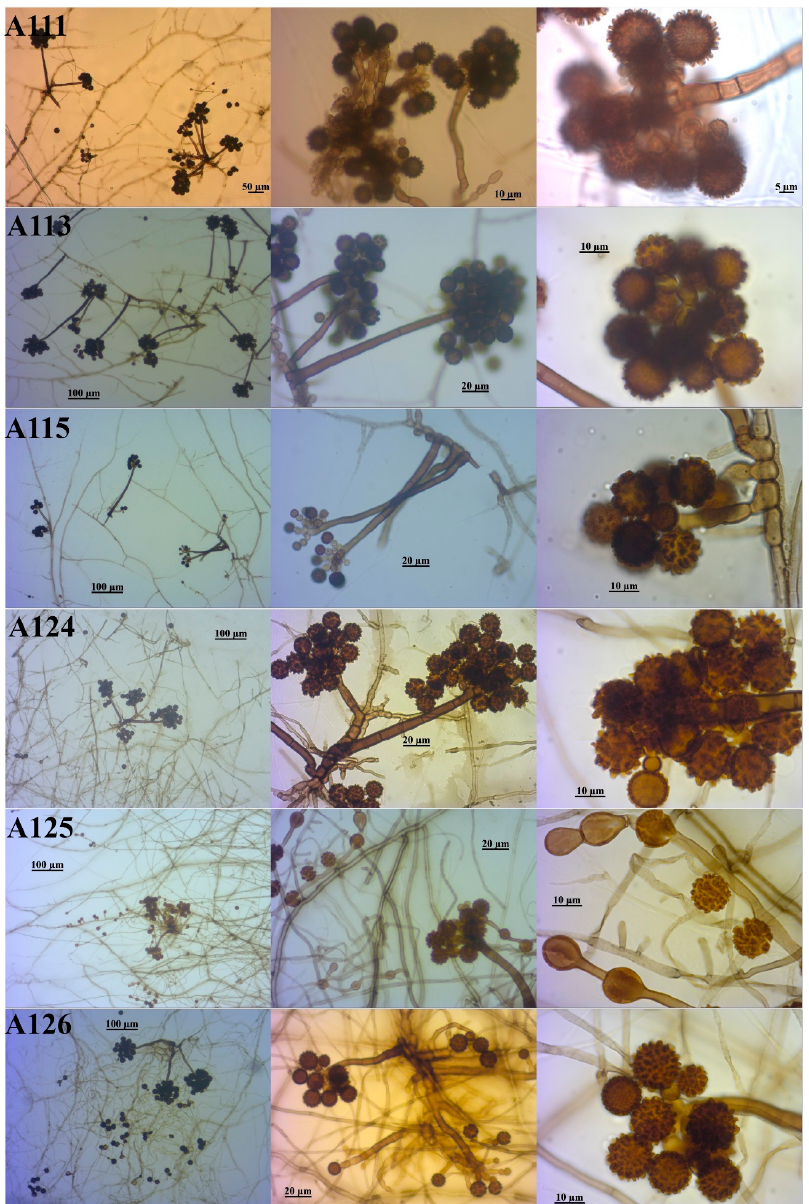
Figure 3. Micromorphology of hyphae and other fungal structures of DSE fungi (A111, A113, A115, A124–A126) grown in malt extract agar after isolation from sugarcane roots sampled in the Quatá region, São Paulo, Brazil.